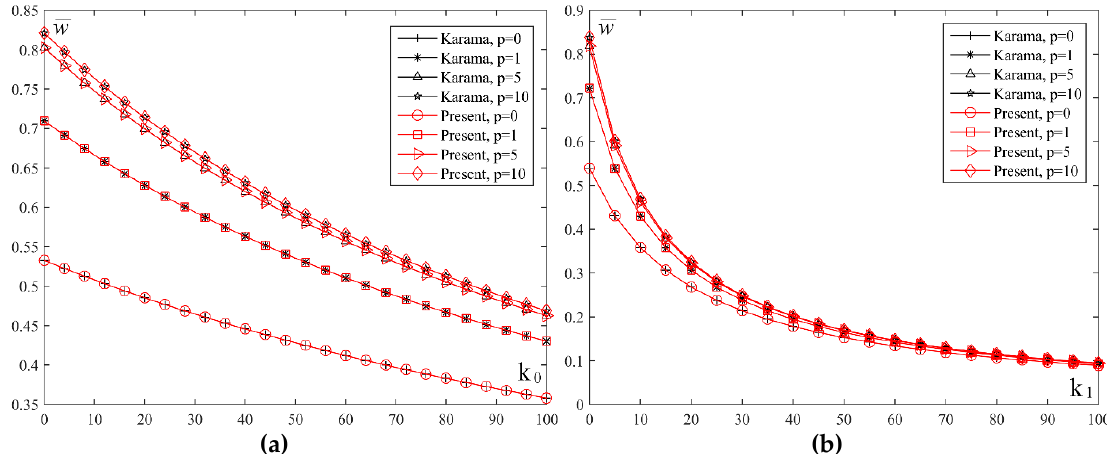
Figure 12. Normalized values of the displacement w of plate on elastic foundation for different values index p and coefficients k 0 and k 1 : ( a ) a/h = 10, a/b = 0.2, k 1 = 10; ( b ) a/h = 10, a/b = 0.2, k 0 = 10.